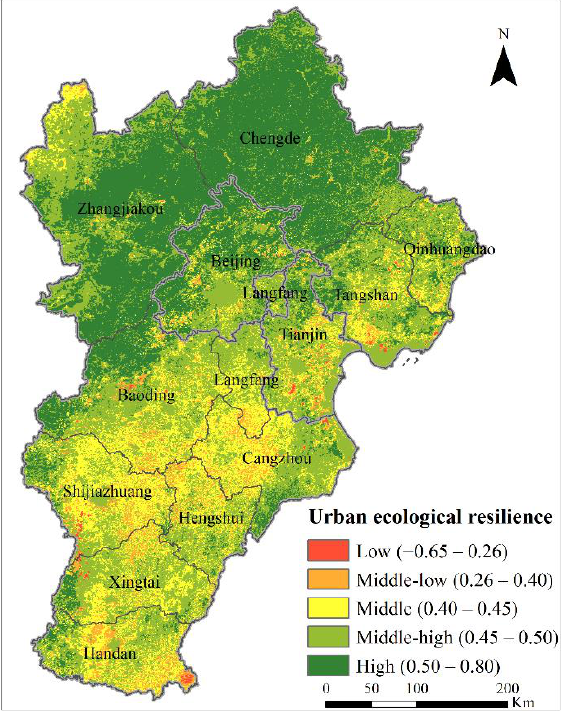
Figure 2. Spatial pattern of urban ecological resilience in the BTHUA region.